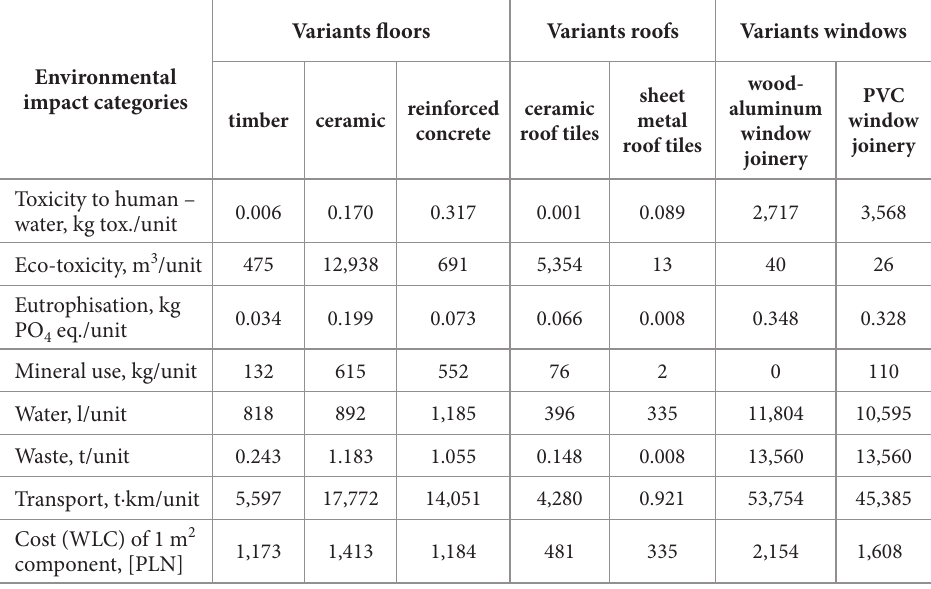
Photochemical smog, kg etene